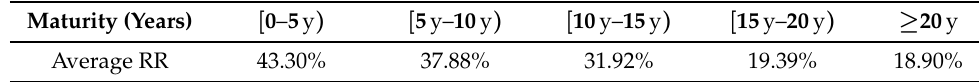
Table 7. Average recovery rate by maturity level.